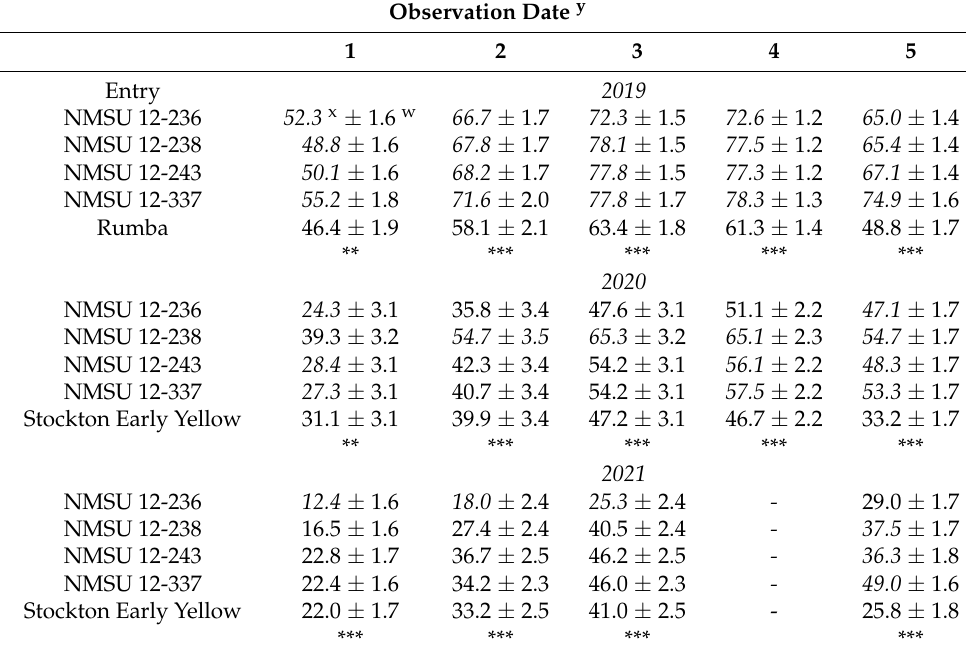
Table 3. Plant height (cm) means measured five times, biweekly, on per plant basis for five onion entries grown at the Fabian Garcia Science Center and Leyendecker Plant Science Research Center, Las Cruces, NM, during the 2019, 2020 and 2021 growing seasons z